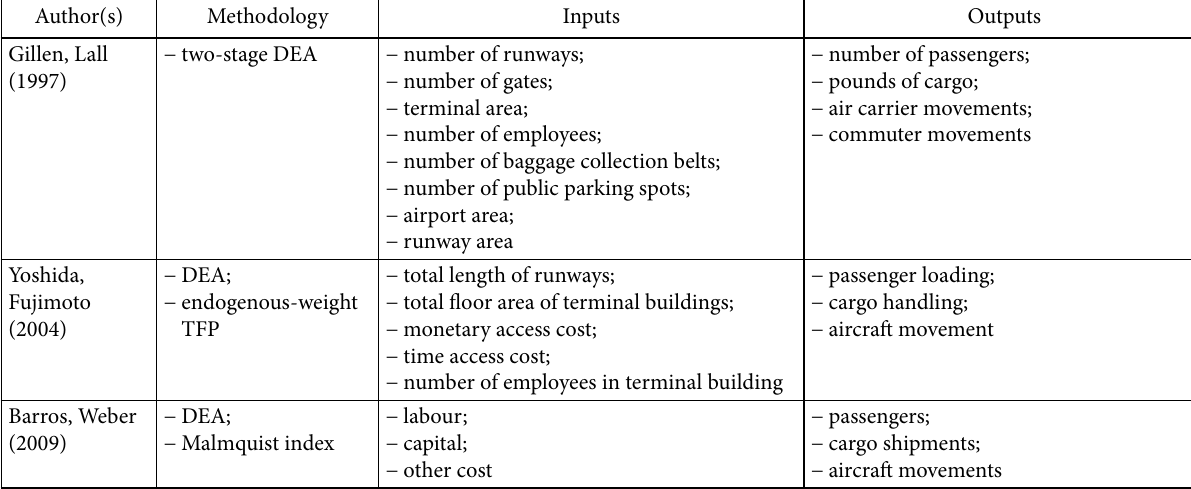
Table 1. Review of the methodology and indicators analysing airport